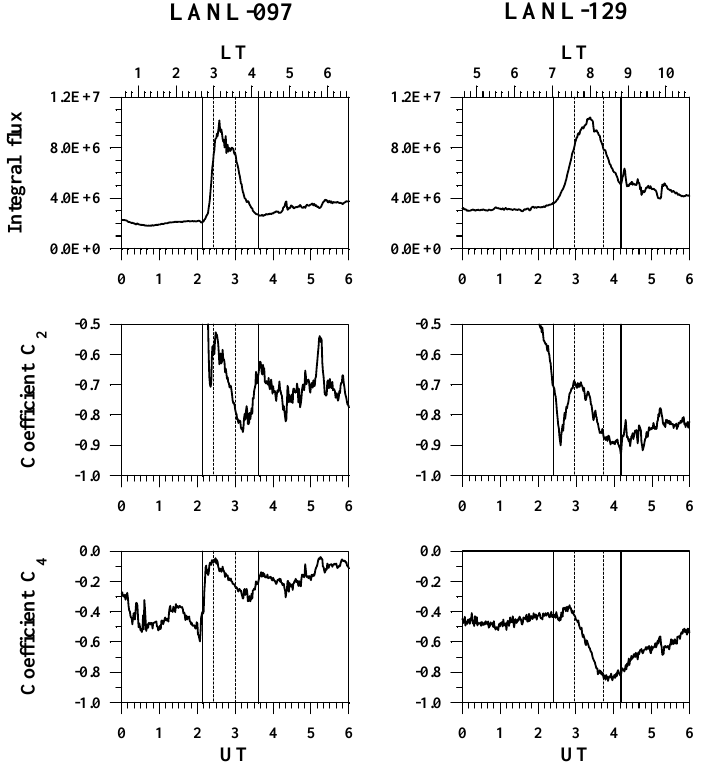
Fig. 6. Omnidirectional integral fluxes with energies above 30keV and the second-( C 2 ) and fourth- ( C 4 ) order harmonics of the Legendre polynomial expansion of the pitch-angle distribution function obtained at two geosynchronous